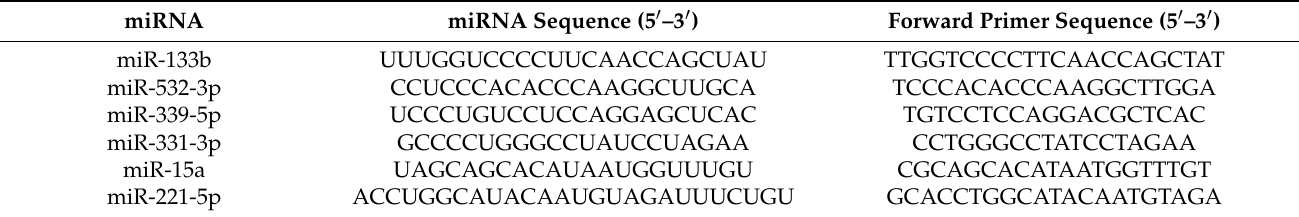
Table 1. miRNA primers for quantitative real-time PCR.